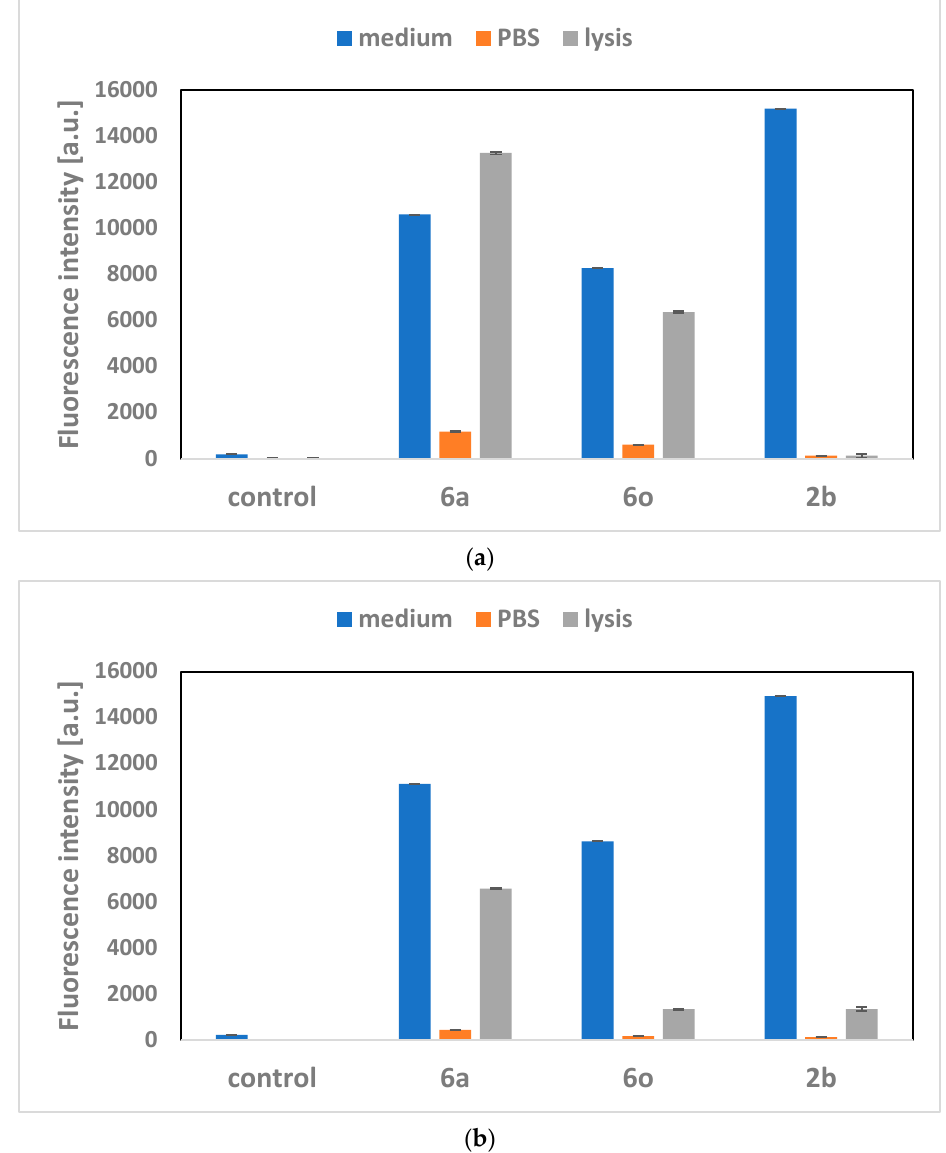
Figure 3. Penetration of porphyrins into cells: ( a ) A549 and ( b ) MCF-7, after incubation of the cells culture with a porphyrin solution. The measured fluorescence intensity of the ‘medium’ samples corresponds to the fluorescence intensity of the porphyrins administered to the cells in the culture medium at the highest concentration (10 µM). ‘PBS’ measurements were made after removing the medium from the cell culture and washing cells with PBS (phosphate-buffered saline). ‘Lysis’ assays refer to the fluorescence intensity of the cells’ lysate after incubation with porphyrins. Based on these measurements, we can find what percentage of the porphyrins administered to the cells (‘medium’ samples) penetrated into them (‘lysis’